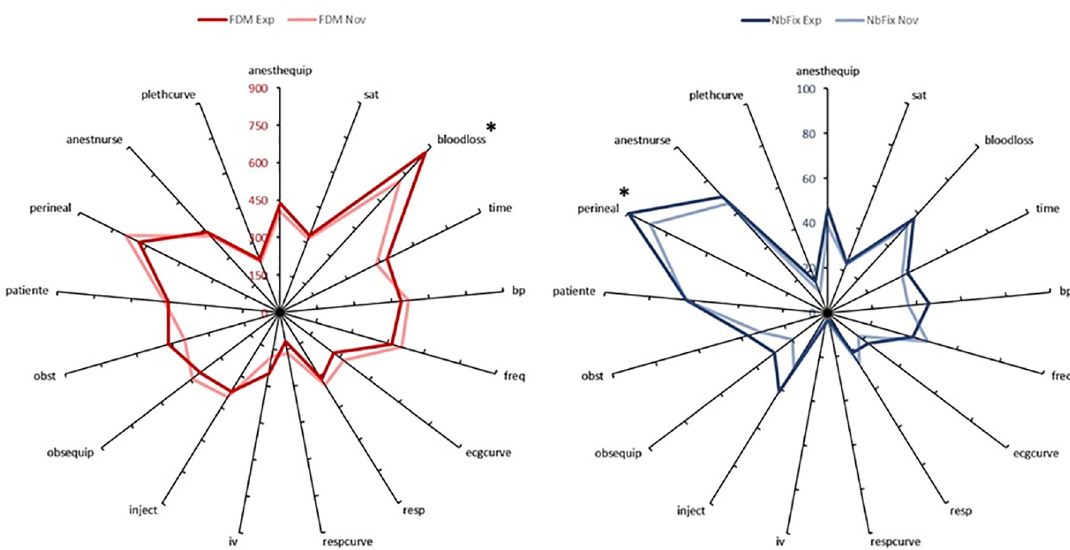
Fig 5. Graphical representation of the fixation number and fixation duration means of Experts and Novices according to the ROI. Presentation of the eye-tracking data by ROI according to the group (Experts or Novices). The graph on the left shows the fixation duration mean (FDM). Experts gazed on average more the ROI “bloodloss” 865 ms compared to 717 ms in Novices. The graph on the right shows the number of fixation (NBF). The post-hoc analysis revealed only difference between Novices and Experts on the ROI “perineal”. The experts will more often gaze this region than the novices (99 versus 89). The overlap of these curves makes it appear that the ROI most often viewed are not those which are viewed the longest.